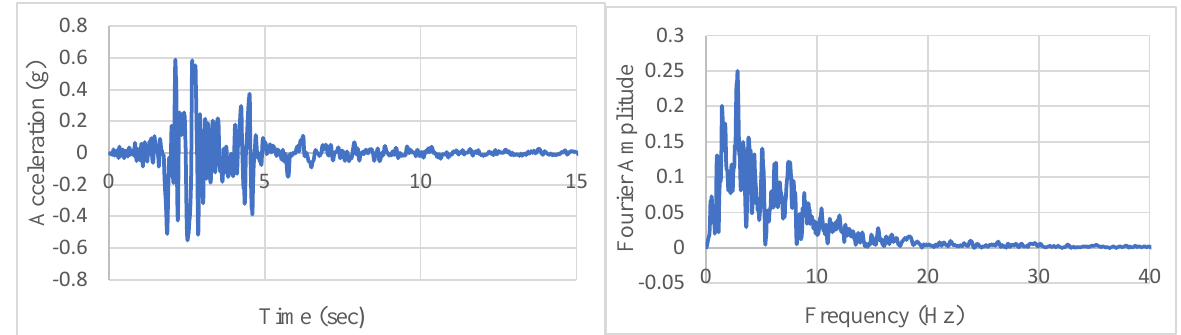
Figure 12. Ground motion record and Fourier spectra: Northridge earthquake.